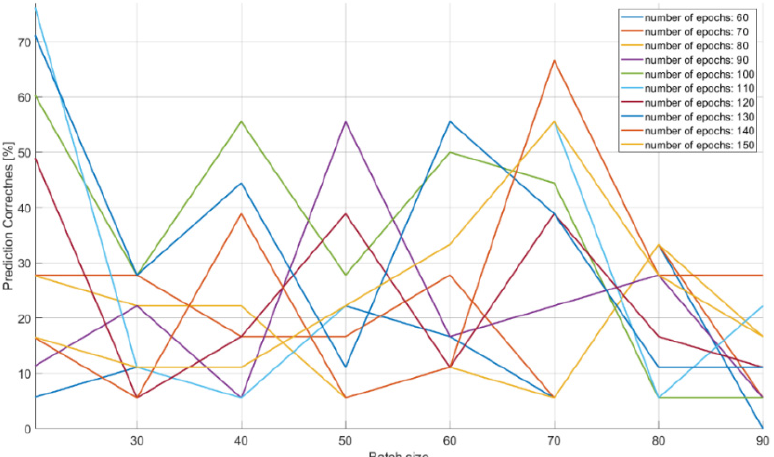
Figure 14. Effectiveness of radar signals recognition on the basis of the PRI parameter in the function of the changes in the size of the training dataset and the number of iterations in the training algo- rithm.